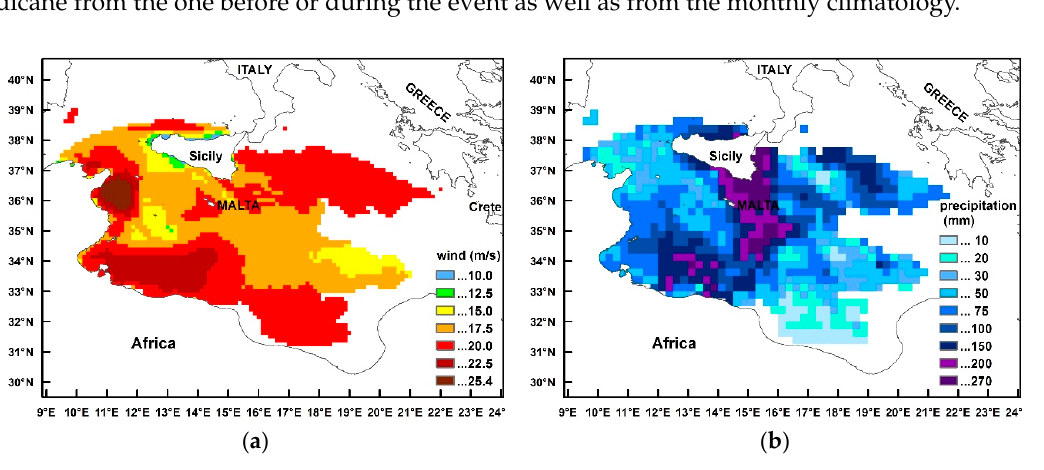
Figure A1. ( a ) Maximum 10 m wind speed during the medicane of 13–15 December 2005; ( b ) Precipitation sum for 12–16 December 2005.